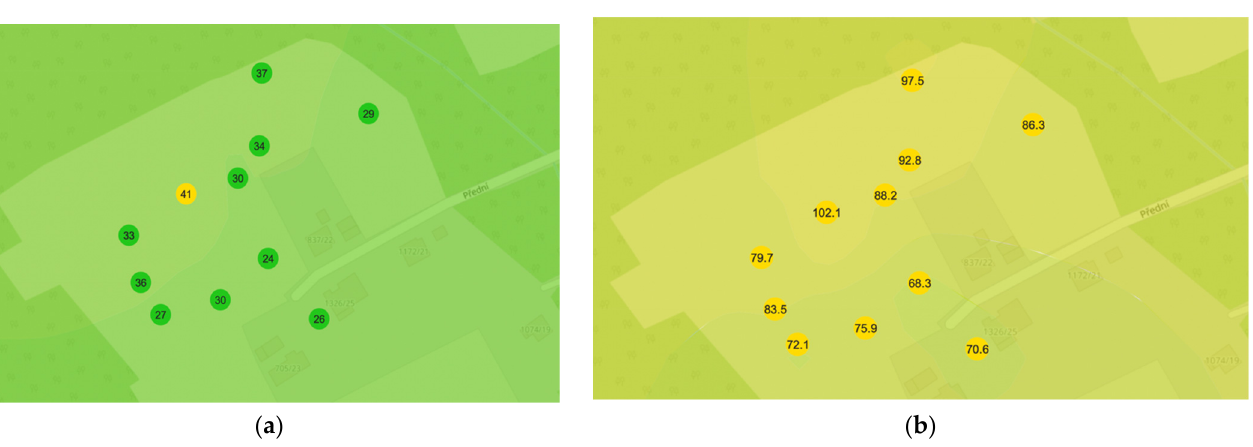
Figure 9. Visualized situation of the air quality based on NO 2 sensor data: ( a ) low average concentrations in the area and ( b ) elevated concentrations of NO 2 .